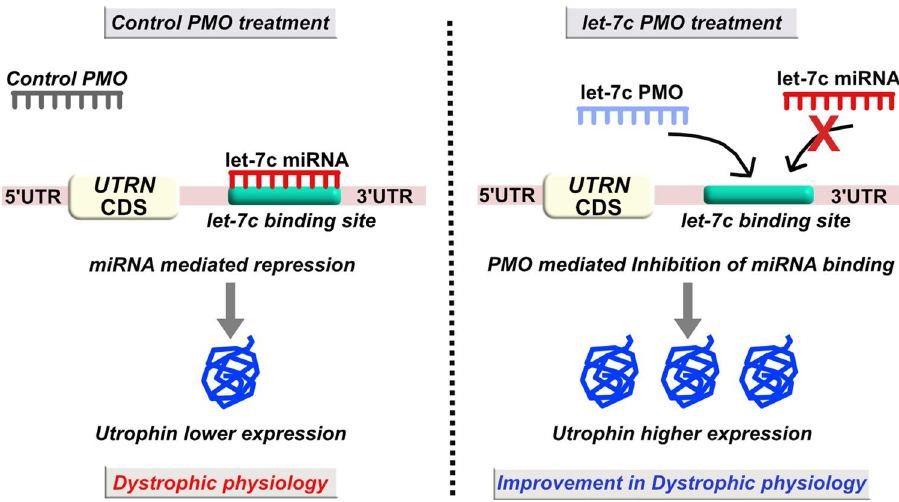
Figure 1. Schematic representation of the PMO-based let-7c SBO strategy to alleviate let-7c miRNA repression of utrophin gene. The left panel shows, let-7c miRNA mediated post-transcriptional repression of utrophin in control PMO treated mice. Whereas, the right panel shows let-7c PMO mediated blocking of miRNA binding to UTRN 3 ′ UTR, resulting in higher utrophin expression and improvement in dystrophic